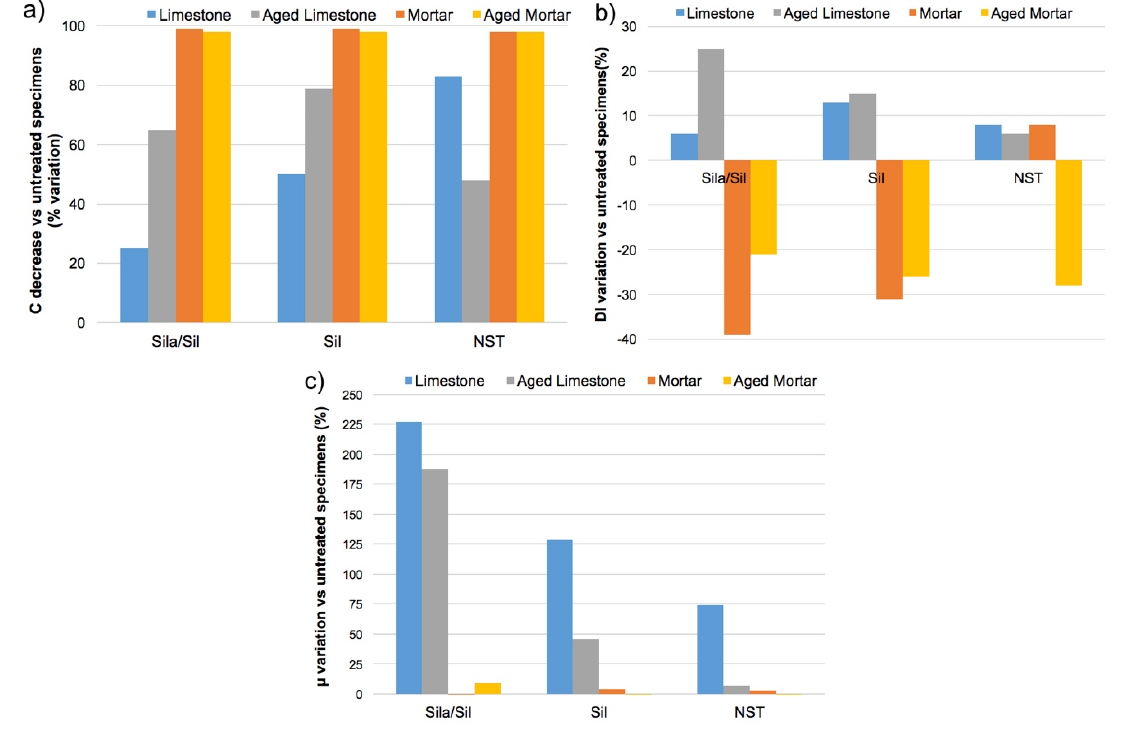
Figure 4. Percentage variation of ( a ) capillary water absorption coefficient (C), ( b ) drying index (DI) and ( c ) diffusion resistance of the water vapor coefficient (µ) of treated specimens, before and after artificial aging, when compared to untreated specimens.